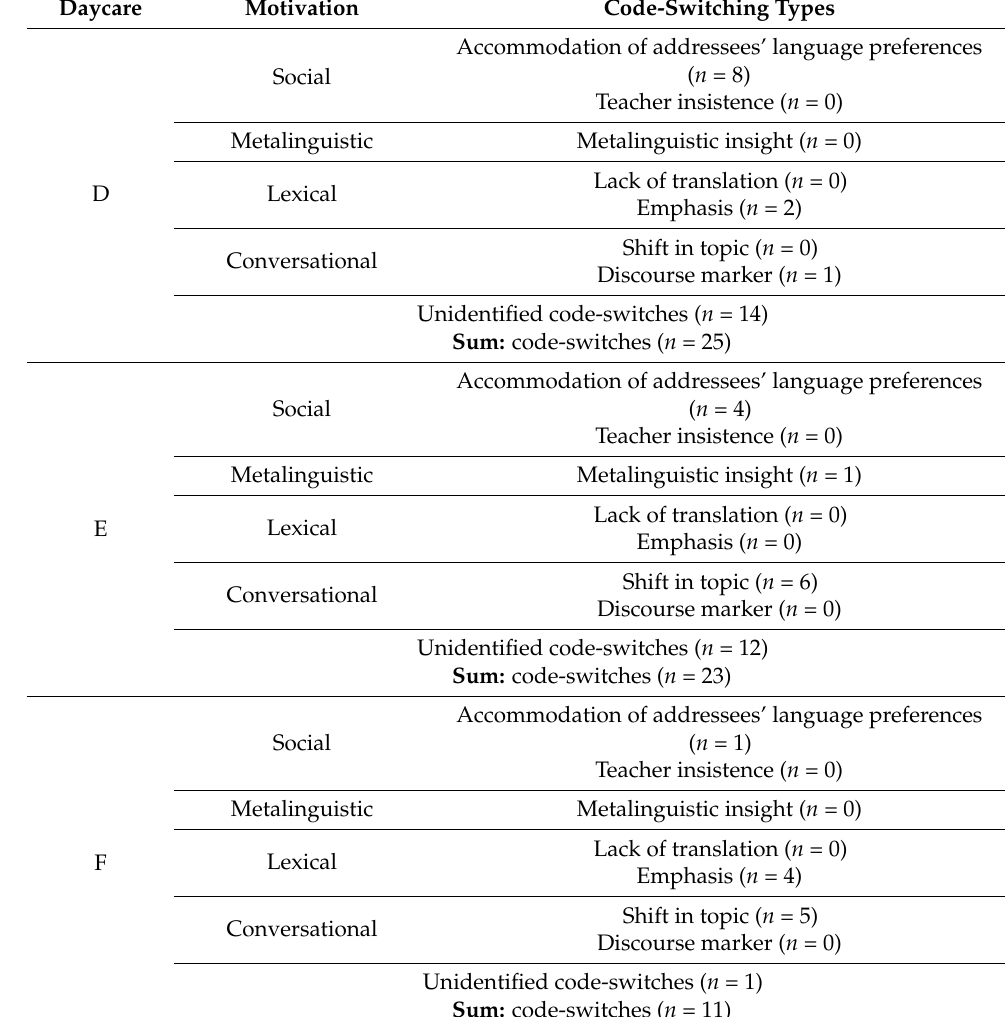
Table A2. Distribution of code-switching types across the Dutch